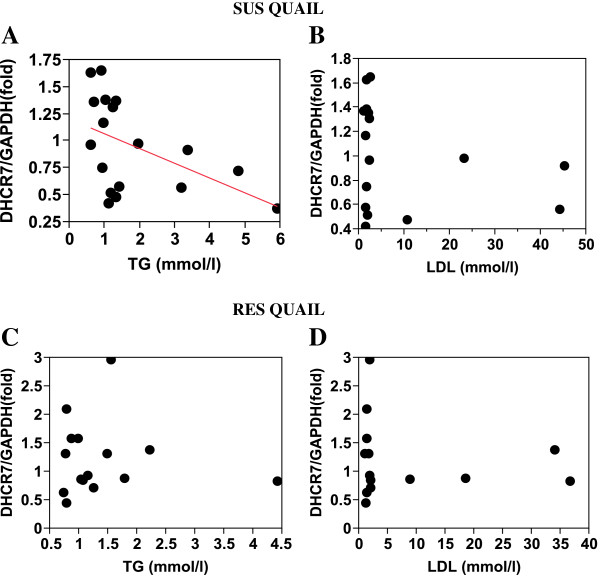
DHCR7expression in SUS and RES liver relative to to plasma triglyceride and LDL levels. In part A: r2 = −0.23; P < 0.04.